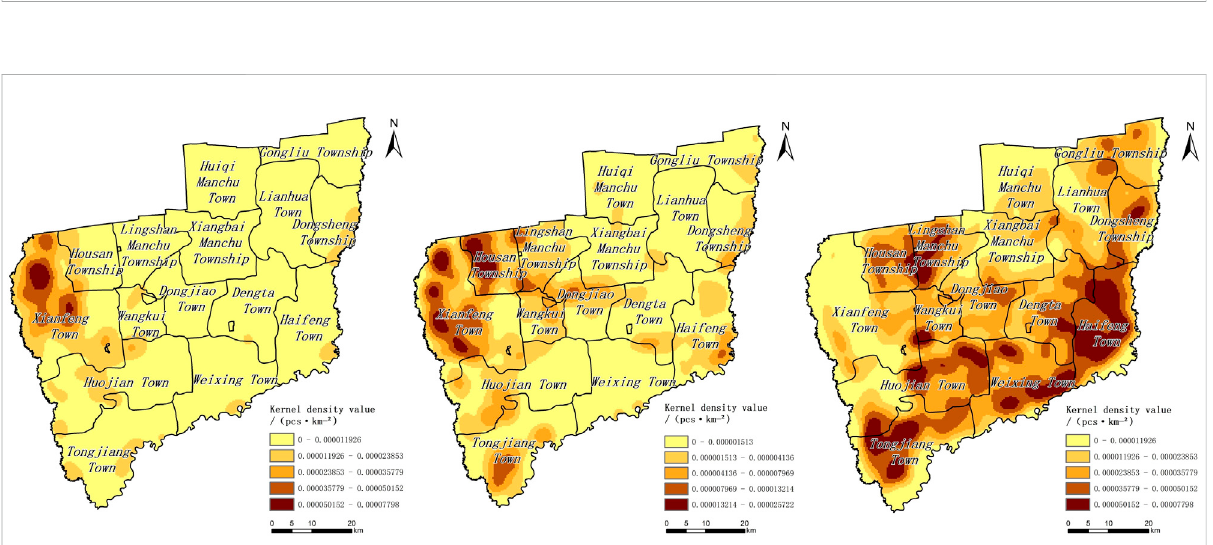
FIGURE 11 Spatial distribution characteristics and evolution of rice – maize rotation pattern.